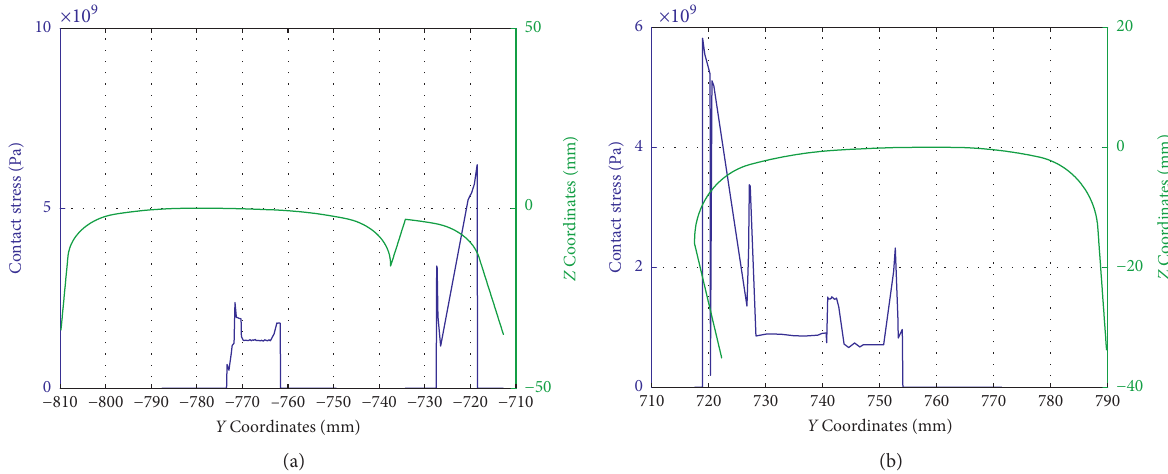
Figure 10: The maximum contact stress between the wheel and switch rail (a) and between the wheel and stock rail (b). The green lines correspond to the rail profile, while blue ones depict the contact stress.